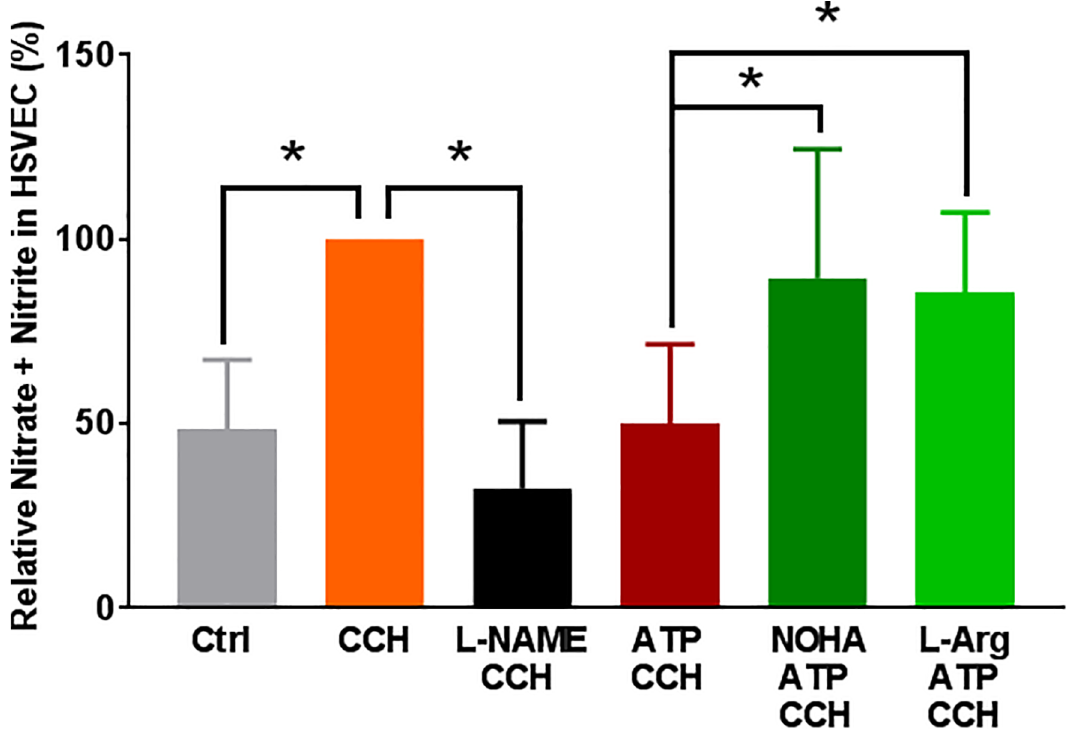
Fig 7. Effect of arginase inhibitor and L-arginine on eATP-induced reduction of nitric oxide production in HSV endothelial cells. HSVEC were either untreated(Ctrl), treated with ATP (2 mM), L-NAME, (100 μ M), ATP with L-arginine (L-Arg, 2 mM), or ATP with NOHA (10 μ M), for 2 hours. The cells were then stimulatedwith carbachol (CCH, 1 μ M) for 10 minutes and the nitric oxide generatedwas measuredas nitrite using the NO assay kit and relative percent of NO generated was calculated. NO generatedwith CCH was set as 100%, n = 6 passages, * p < 0.05, (One way ANOVA).